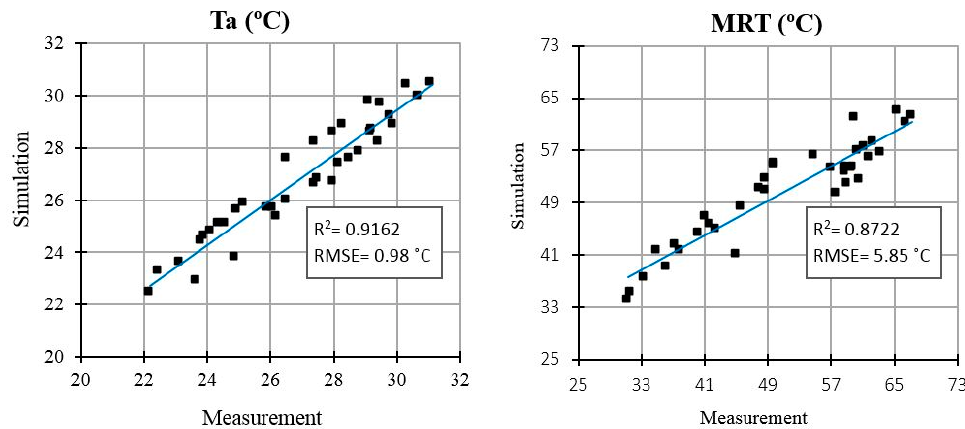
Figure 5. Relationship between ENVI-met simulated and measured data of Ta MRT (09:00–17:00 local